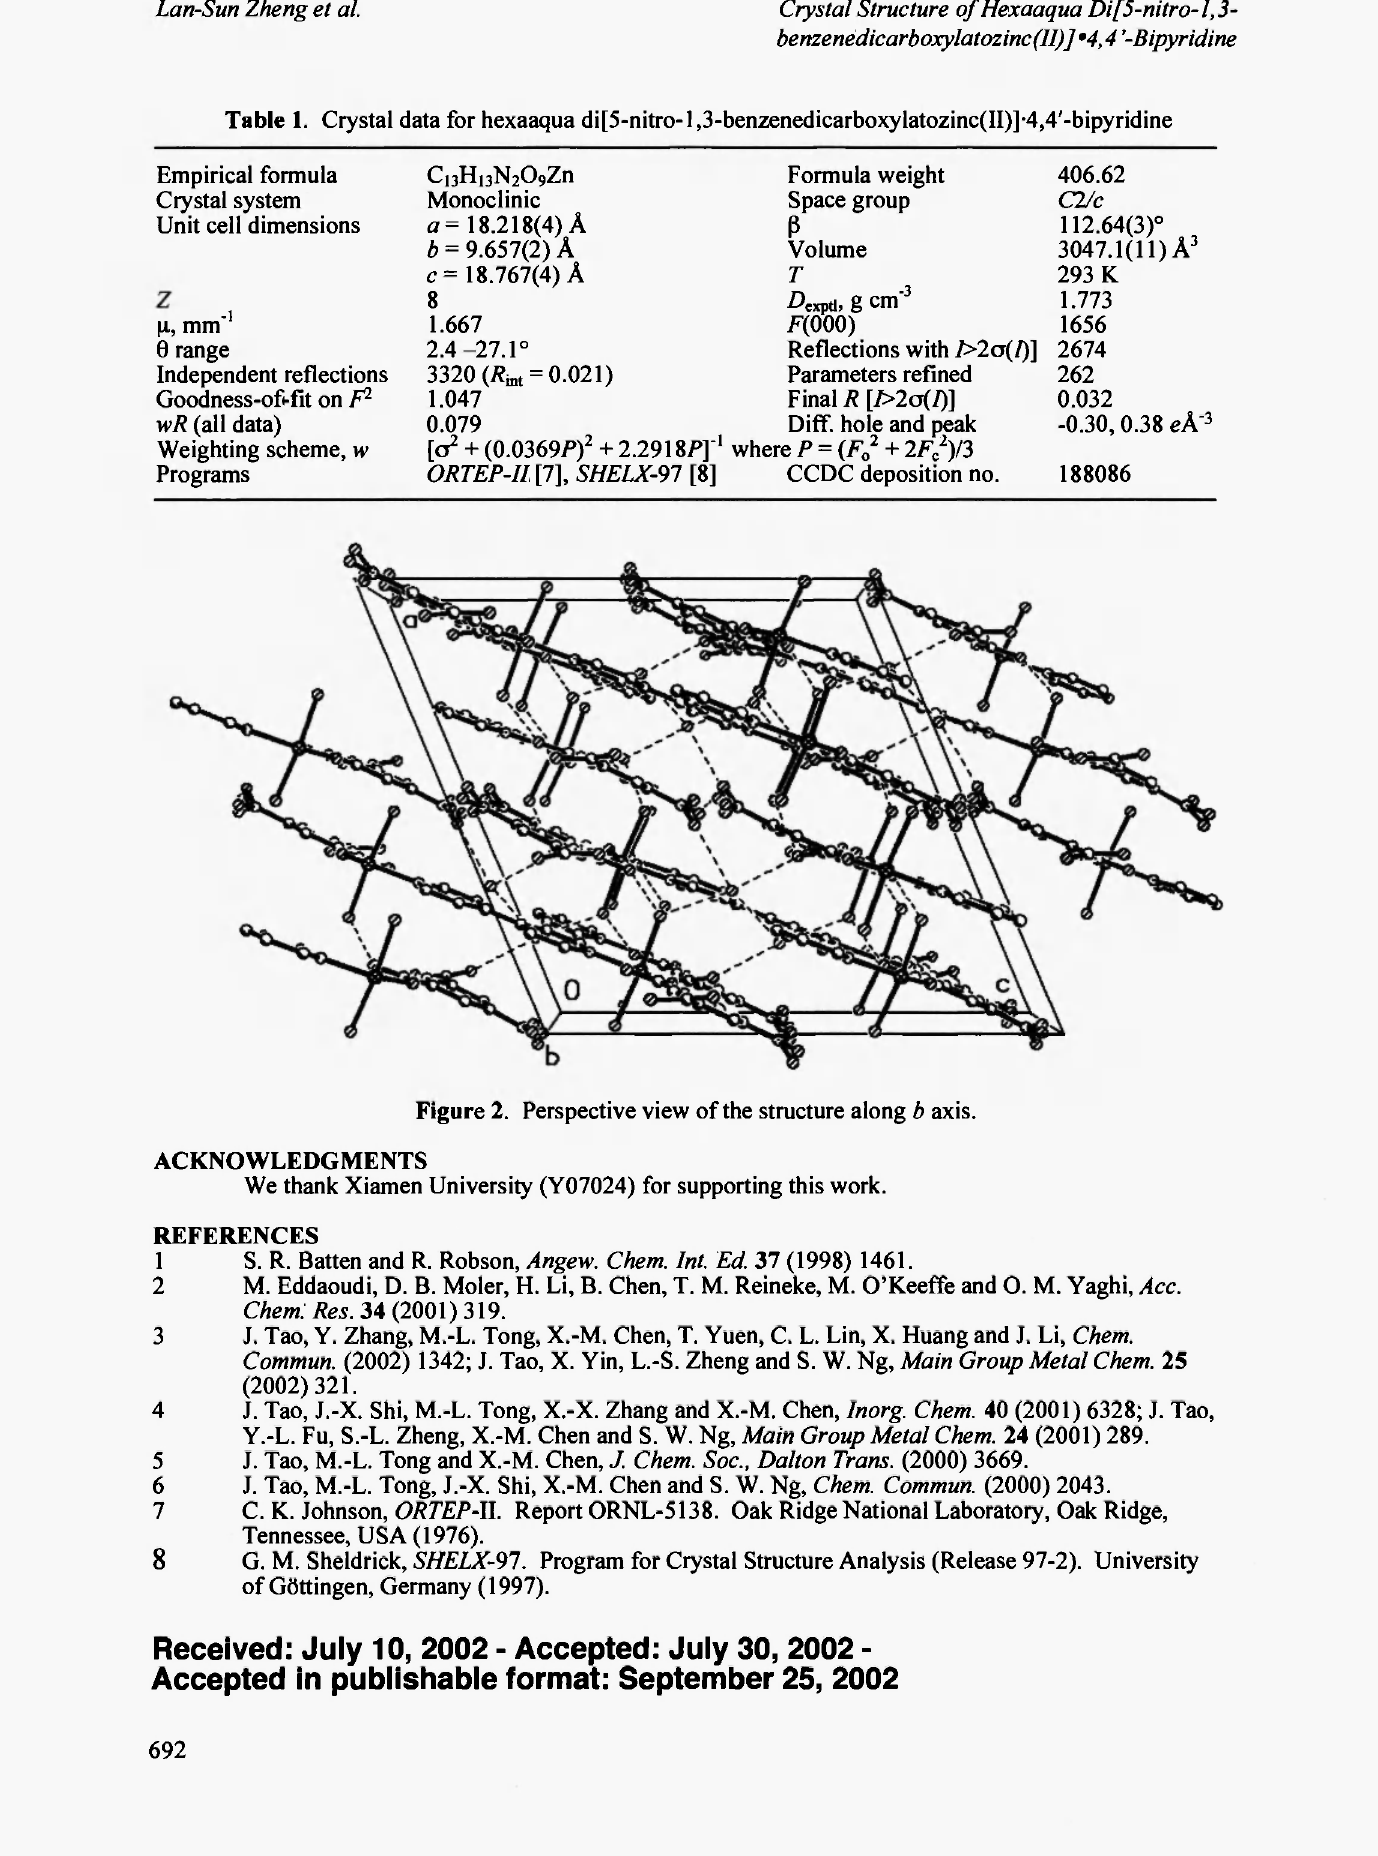
Figure 2. Perspective view of the structure along b